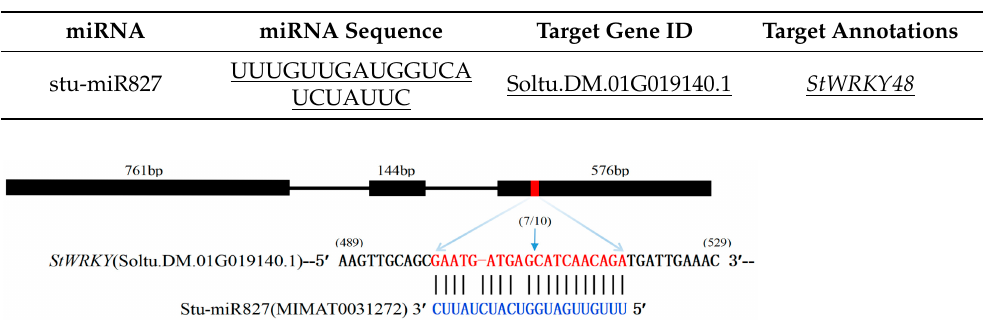
Figure 6. RLM-5 ′ RACE verification of target mRNA cleavage sites generated by stu-miR827. Frac- tions within parentheses are the proportions of 5 ′ RACE clones showing these cleavage sites out of (cid:48) RACE clones showing these cleavage sites out of all all sequenced clones. within parentheses are the proportions of 5 sequenced